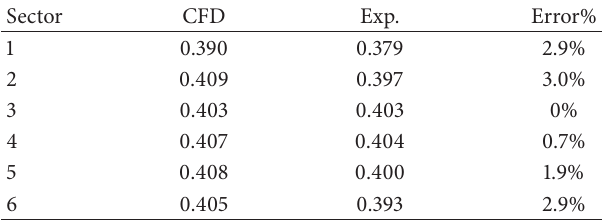
Figure 6: Comparison of CFD and test results for water. Table 2: Results of averaged static pressure 𝑝 ∗ on casing wall at BEP in six sectors around the impeller ( 𝑟 = 107 mm).